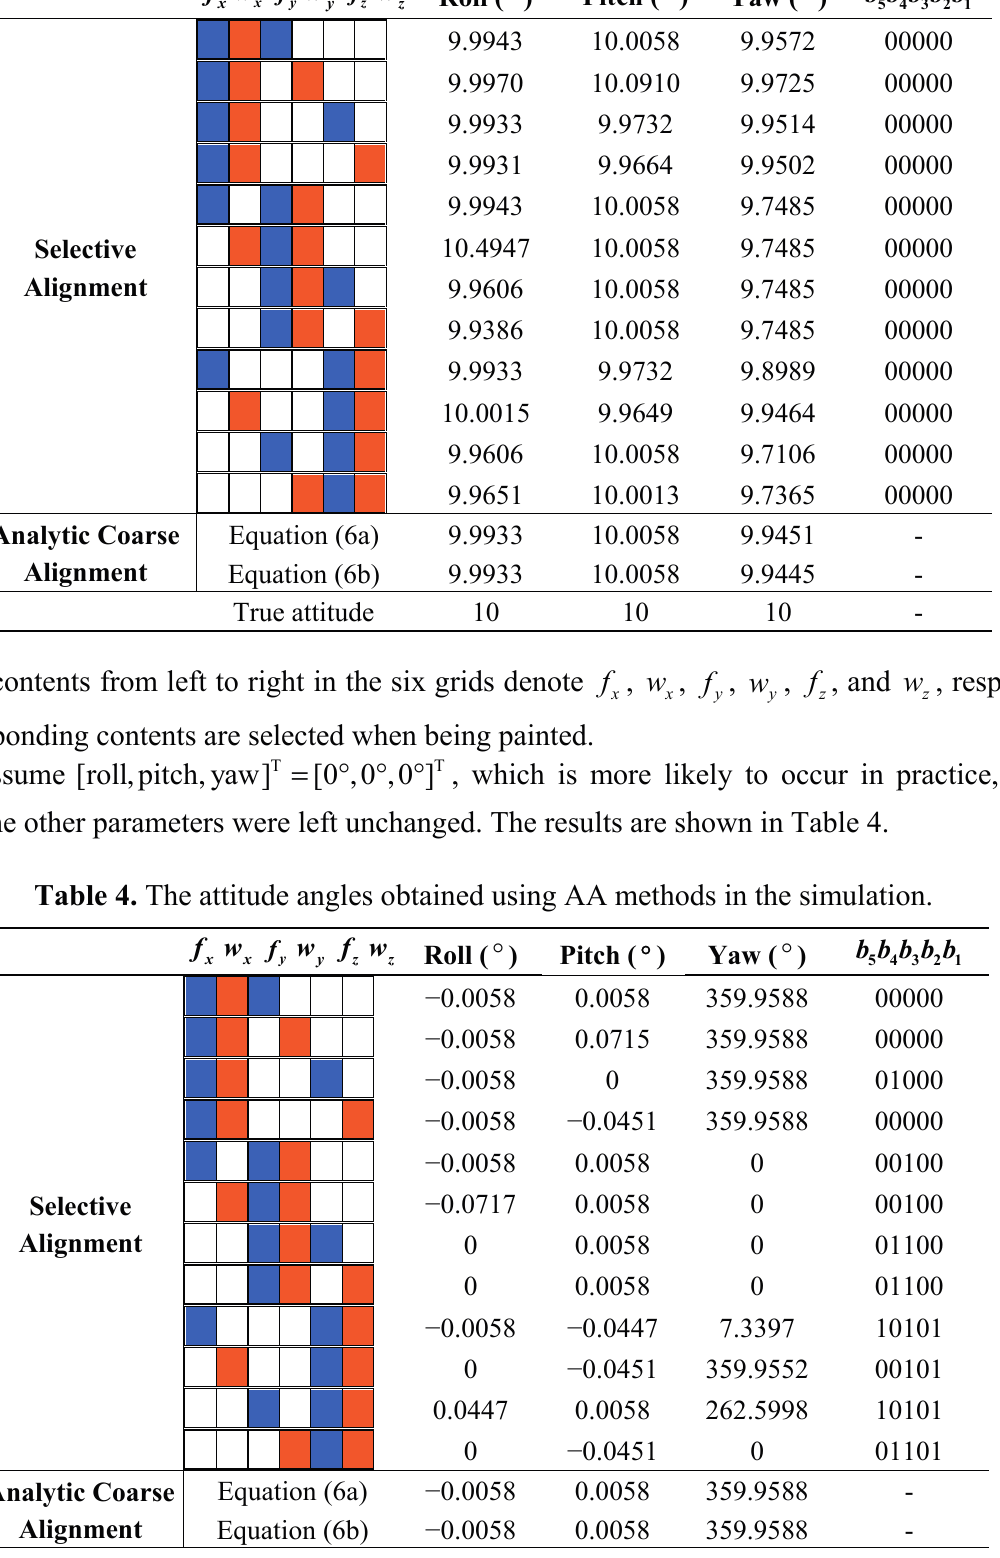
Table 3. The attitude angles obtained using analytic alignment (AA) methods in the simulation. x